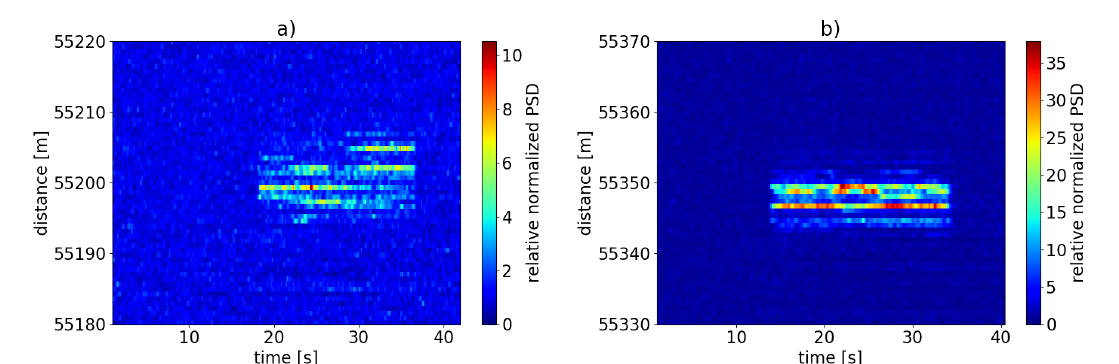
Figure 12. Normalized sum of power spectral density (PSD) at excitation frequency f = 80 Hz and its harmonics (Equation (8)) at a measurement distance of 55 km on the basis of the spectral data shown in Figure 11a) for unmodified standard SMF; ( b ) for the case using fiber-inscribed scattering dots. The increase in sensitivity and the difference in fading behavior is clearly visible. Note the different scales of the color coding.